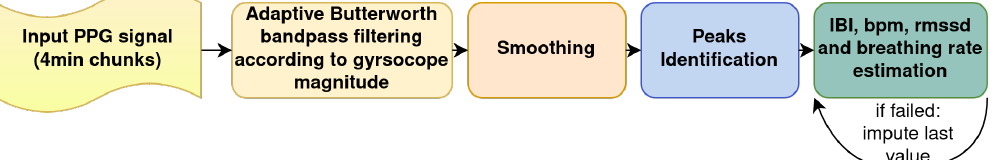
Figure 5. Preprocessing of the PPG signal and the extraction of